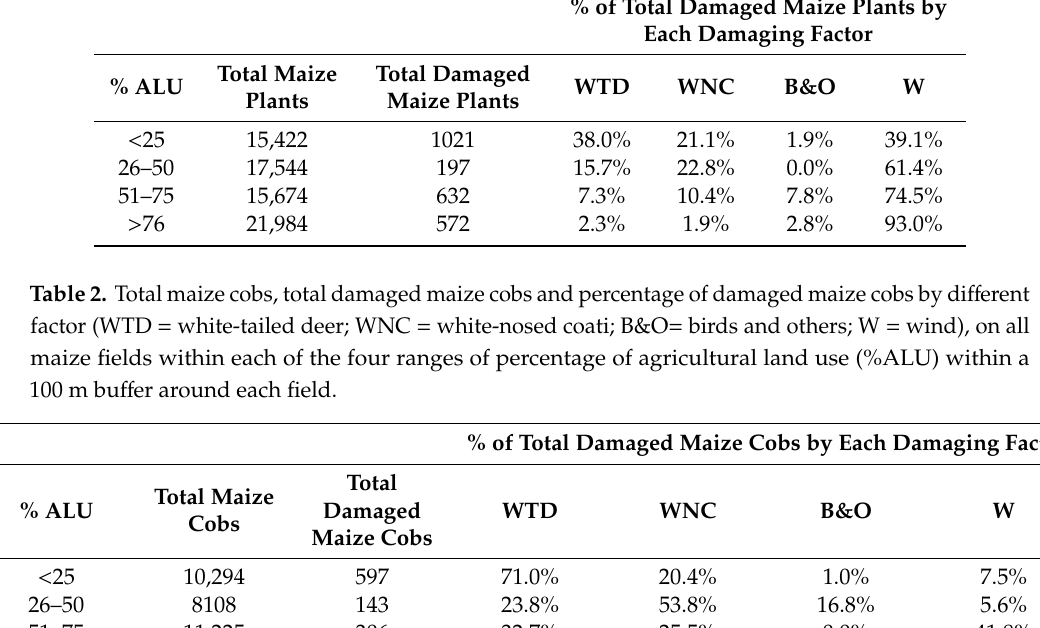
Table 1. Total maize plants, total damaged maize plants and percentage of damaged maize plants by di ff erent factor (WTD = white-tailed deer; WNC = white-nosed coati; B&O = birds and others; W = wind), on all maize fields within each of the four ranges of percentage of agricultural land use (%ALU) within a 100 m bu ff er around each field.